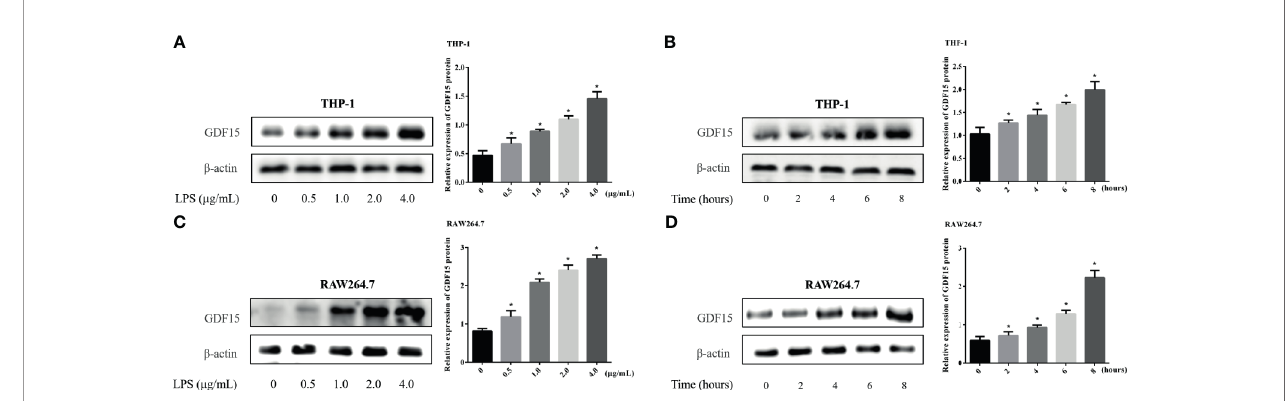
FIGURE 8 | Changes of GDF15 protein expression in THP-1 and RAW264.7 cells stimulated by LPS. The protein expression was detected by Western blot, and the picture showed the protein bands and their quantitative analysis results. (A) THP-1 cells stimulated by gradient concentration of LPS; (B) THP-1 cells stimulated by gradient time of LPS; (C) RAW264.7 cells stimulated by gradient concentration of LPS; (D) RAW264.7 cells stimulated by gradient time of LPS. * P < 0.05, compare with the blank group.